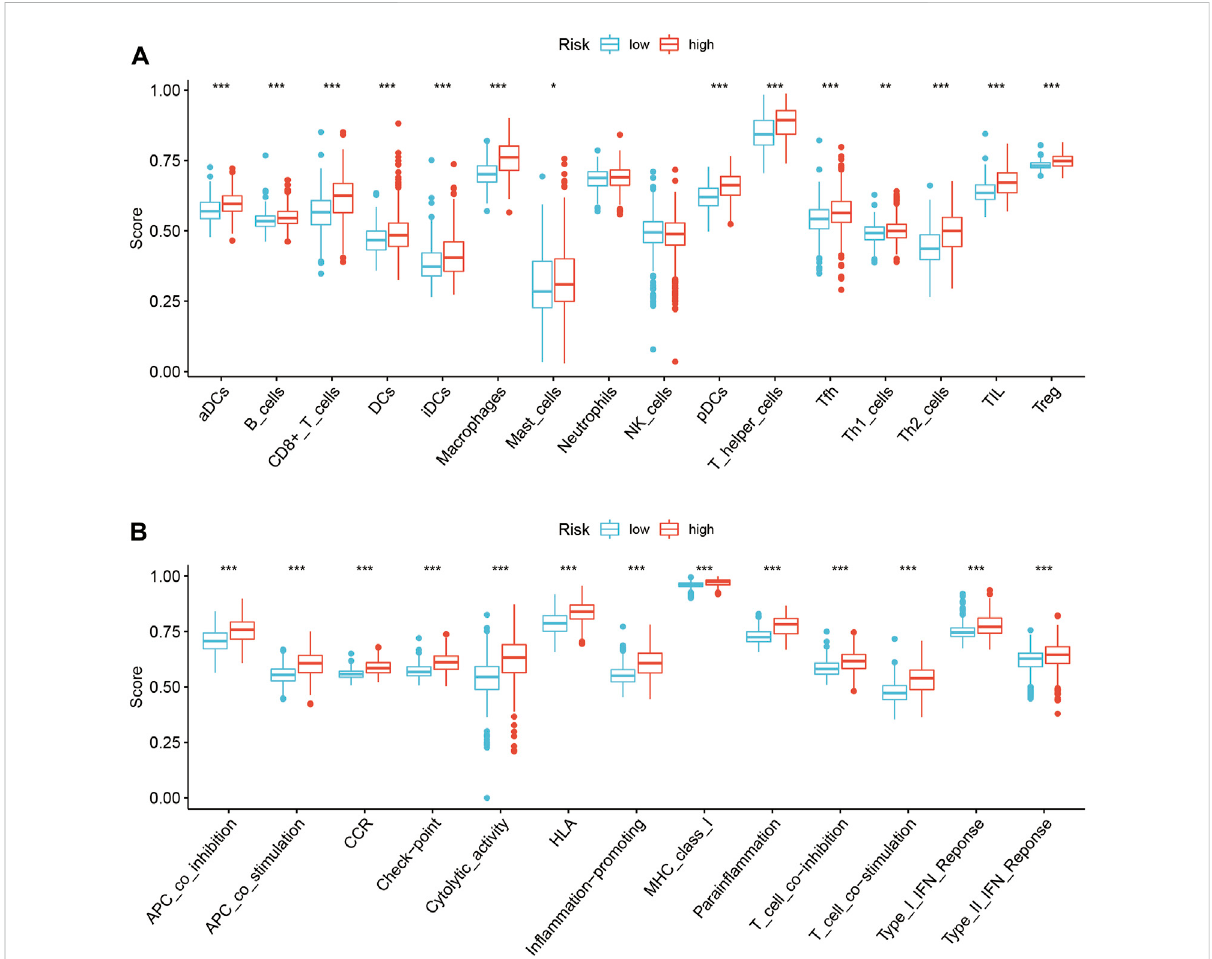
FIGURE 7 Relationship between theSIRT-based signature andimmunecharacteristics ofgliomapatients. (A) ThessGSEA algorithm wasusedto calculate the difference in immune cell in fi ltration between HR and LR glioma patients in the TCGA database. (B) The ssGSEA algorithm was used to calculate the difference in immune status scores between high and LR groups in the TCGA database (* p < 0.05, ** p < 0.01, *** p < 0.001, ns: p >